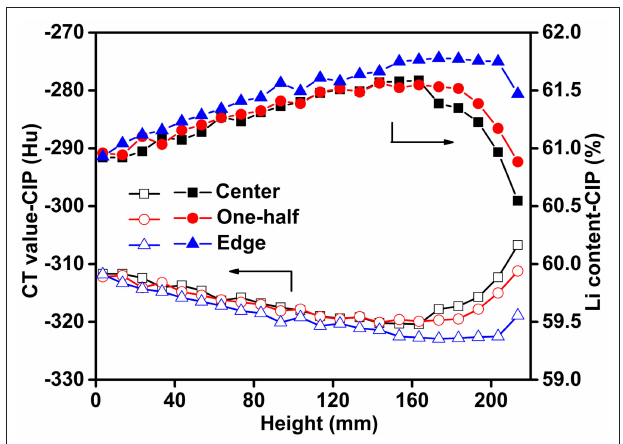
FIGURE 8 | Li spatial distribution derived from the CT values.